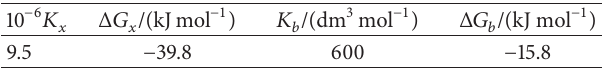
Table 4: The data of partition coefficient ( 𝐾 𝑥 ), free energy of partition ( Δ𝐺 𝑥 ), binding constant ( 𝐾 𝑏 ), and free energy of binding ( Δ𝐺 𝑏 ) for reactive red 223/CTAB